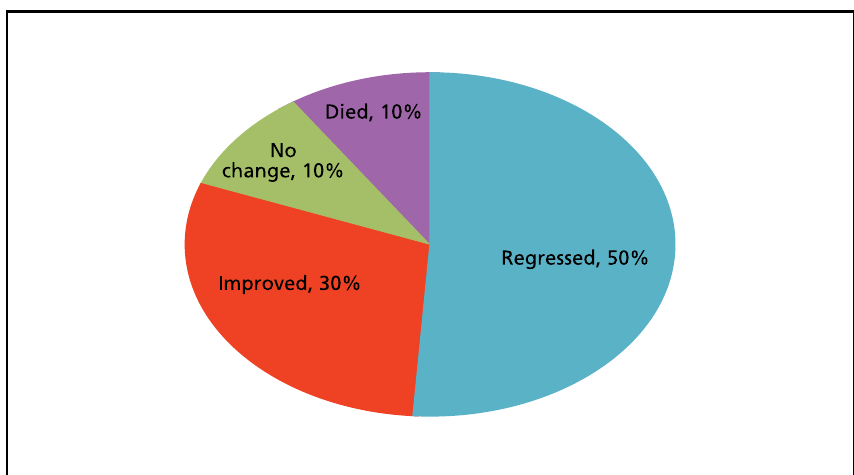
Figure 4: condition of patients with a stroke (n=94) since